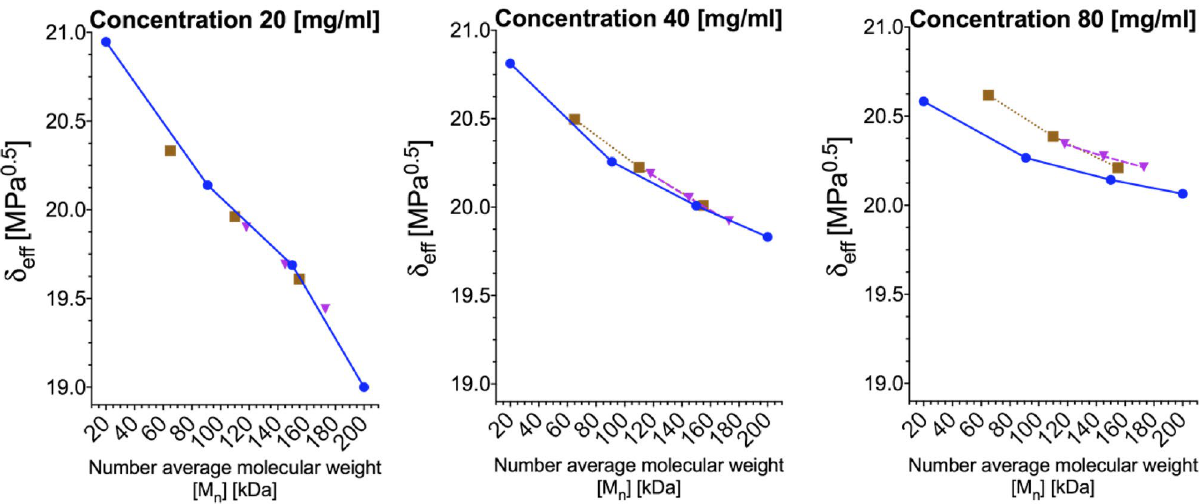
Figure 10. The effective miscibility parameter δ eff of the polystyrenes in MEK with bimodal and uniform distributions for two kinds of bimodal distributions: 20 kDa/200 kDa—brown squares and 91 kDa/200 kDa— purple triangles; the blue circles represent data for polystyrenes with uniform distributions. [M n ] = f 1 M w1 + f 2 M w2 , where f w/w % ratio of